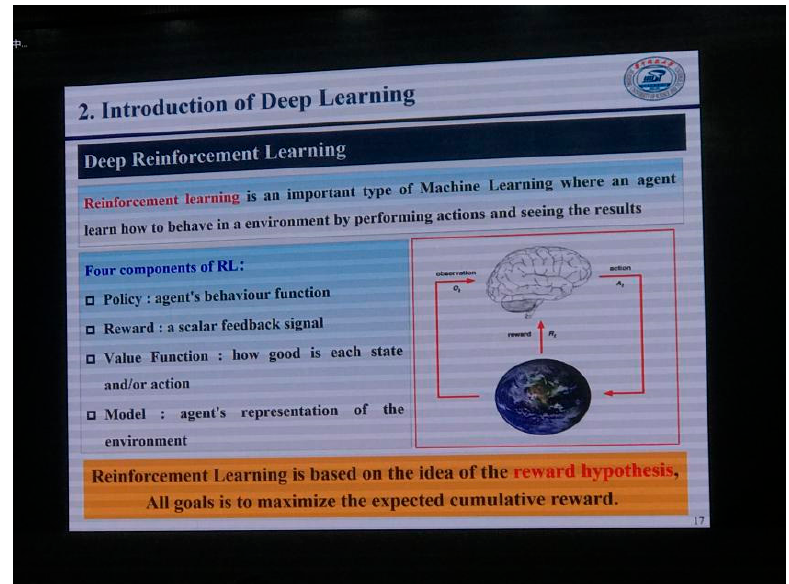
Figure 5. The speech of Professor Gao Liang: Introduction of Deep Learning.